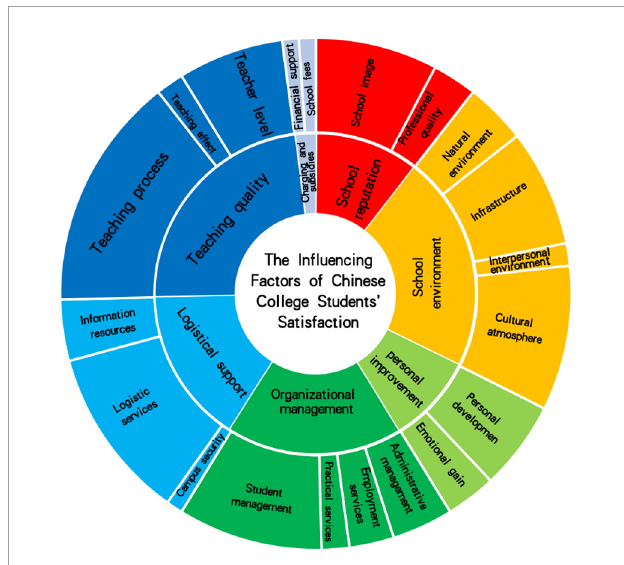
FIGURE3 Structural model of influencing factors of college students’ satisfaction. Due to the large number of tertiary nodes, only primary and secondary nodes are listed in the